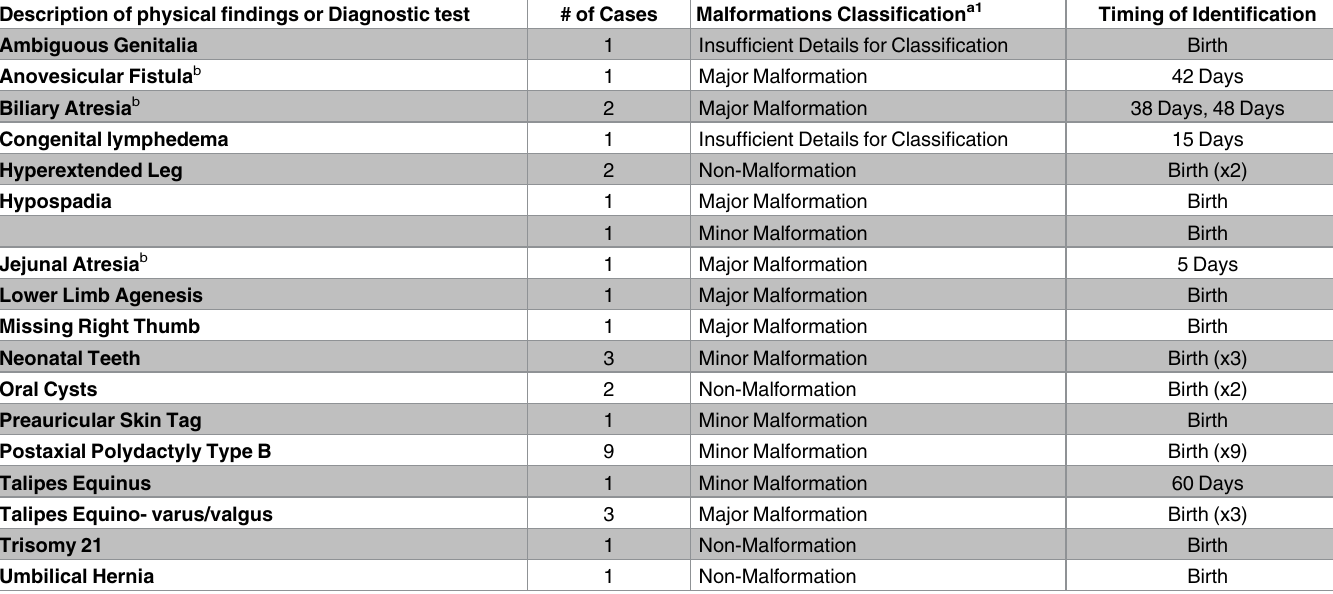
Table 2. Abnormal infant findings, timing of identification and subsequent congenital malformations